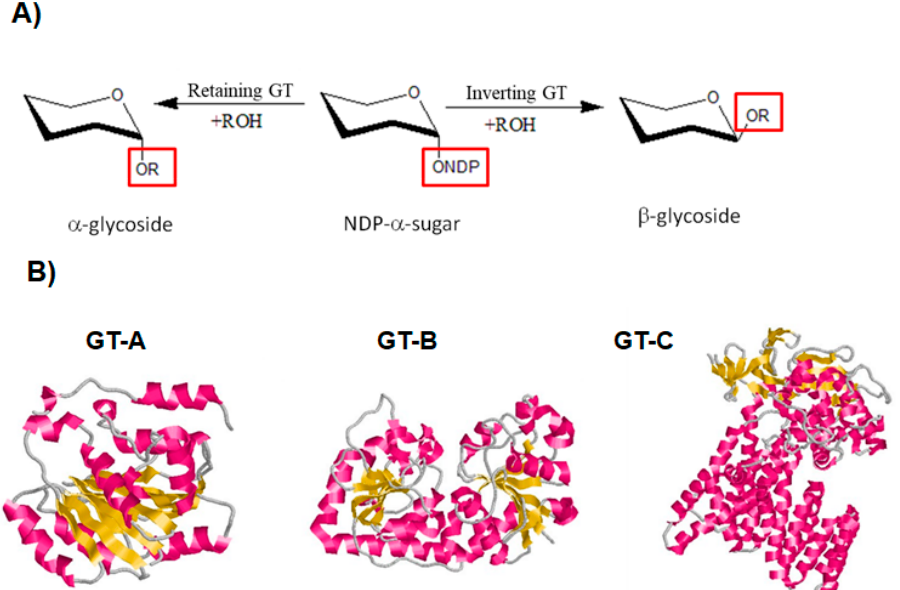
Figure 6. Classification of GTs based on their mechanism for the catalysis of glycosyl group transfer and on their 3D structure [126–128]. ( A ) Schematic diagram showing inverting and retaining GTs. ( B ) Classification of GTs based on their 3D structure. Diagram of GT-A fold protein represented by SpsA protein from Bacillus subtilis (Protein Data Bank (PDB ID: 1QGQ), diagram of GT-B fold represented by the β -glucosyltransferase of bacteriophage T4, (PDB ID: 1JG7) and diagram of GT-C fold represented by the oligosaccharyltransferase protein from Campylobacter lari in complex with peptide substrate and magnesium (PDB ID: 3RCE). The helices are shown in pink, β -strands in yellow and loops in grey.